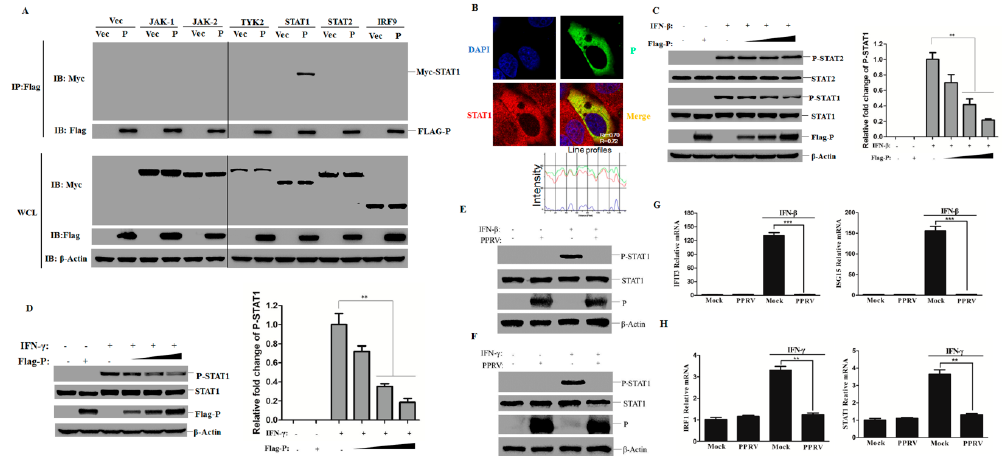
Figure 6. PPRV P protein binds to STAT1 and inhibits STAT1 phosphorylation. ( A ) HEK-293T cells were transfected with Flag-P expressing plasmids and Myc-tagged JAK1, JAK2, TYK2, STAT1, STAT2, and IRF9 expressing plasmids. The cells were lysed and subjected to immunoprecipitation and immunoblotting analysis similar as described in Figure 4A. ( B ) HeLa cells were transfected with P protein expressing plasmids for 24 h, the colocalization of P (Green) and STAT1 (Red) was determined by IFA, the nucleus was stained with DAPI (Blue). The overlapping coefficient ( r ) and Pearson’s correlation ( R 2 ) values were further determined in the merged image. The intensity profile of the linear region of interest (ROI) across a HeLa cell co-stained with P and STAT1 is presented below the merged image. ( C and D ) HEK-293T cells were transfected with increasing amounts of P protein expressing plasmids (1, 2 or 3 μ g). The cells were treated with IFN- β (1000 U/mL) ( C ) or IFN- γ (100 ng/mL) ( D ) at 24 h post-transfection for 30 min. The relative fold change of p–STAT1 was